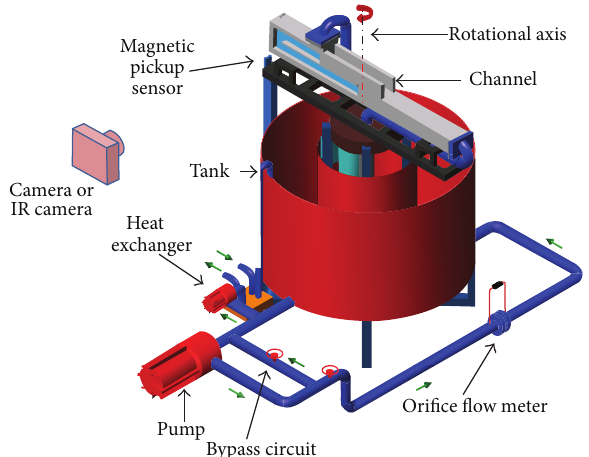
Figure 14: Experimental apparatus for a rotating channel of Gallo et al.